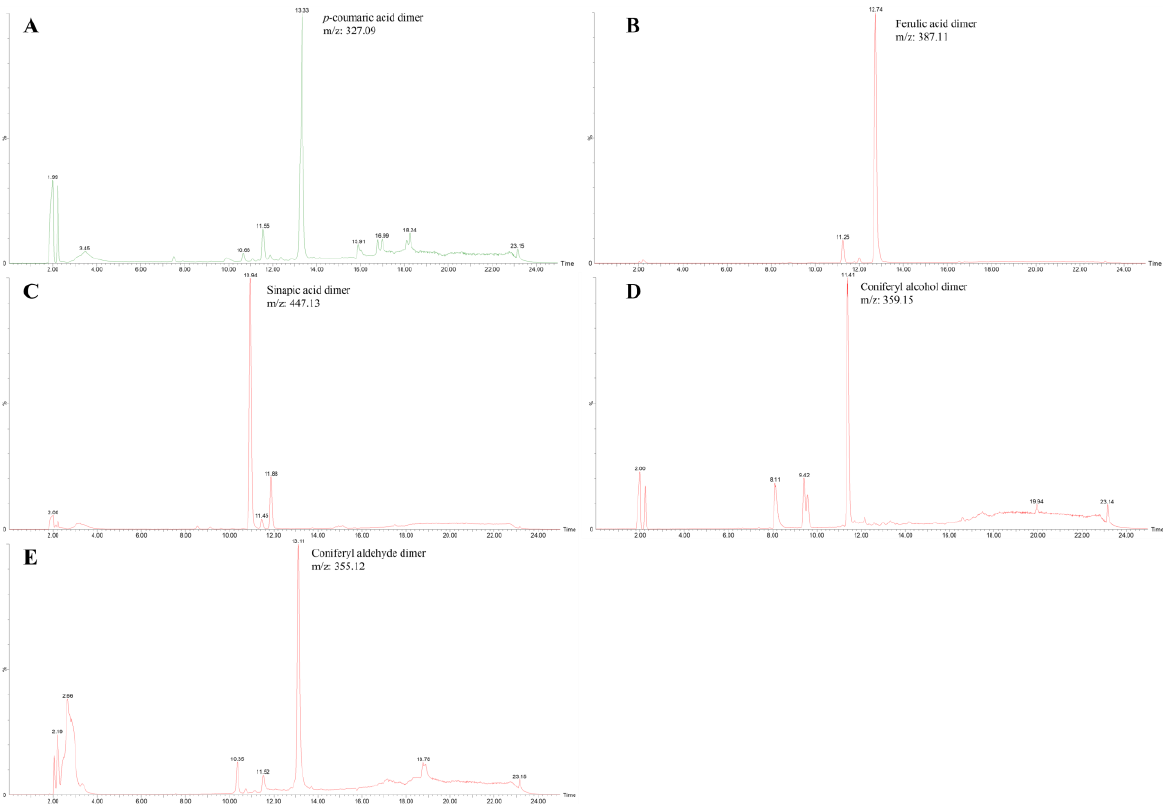
Figure A2. HPLC chromatogram of the reaction products of the H 2 O 2 -dependent oxidation of phenylpropanoids. ( A ) shows the p -coumaric acid dimer with m / z 327.09; ( B ) shows the ferulic acid dimer with m / z 387.11; ( C ) shows the sinapic acid dimer with m / z 447.13; ( D ) shows the coniferyl alcohol dimer with m / z 359.15; ( E ) shows the coniferyl aldehyde dimer with m / z 355.12. The x -axis is a retention time and the y -axis, intensity, is scaled to the highest